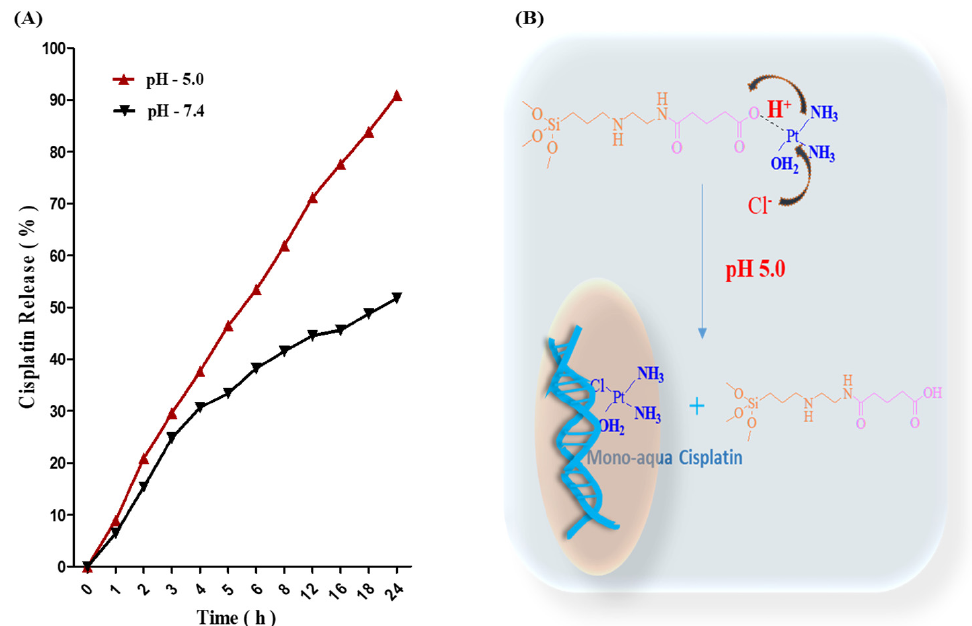
Figure 7. ( A ) The pH-dependent (pH 5.0 and 7.4) CP release for 24 h, ( B ) a diagram illustrating the mechanism of CP release in cancer cells, and highly active monoaqua CP binding to DNA.